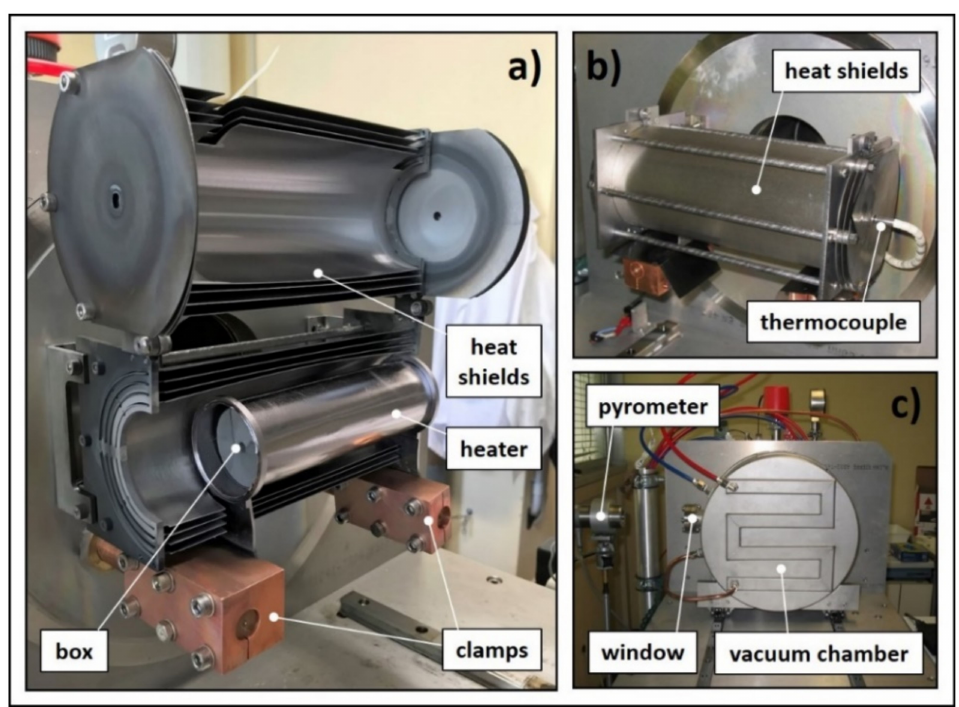
Figure 5. The experimental apparatus used to determine the temperature limit of target materials; ( a ) picture of the opened hot zone; ( b ) picture of the closed hot zone; ( c ) picture of the water-cooled vacuum chamber and of the temperature measurement